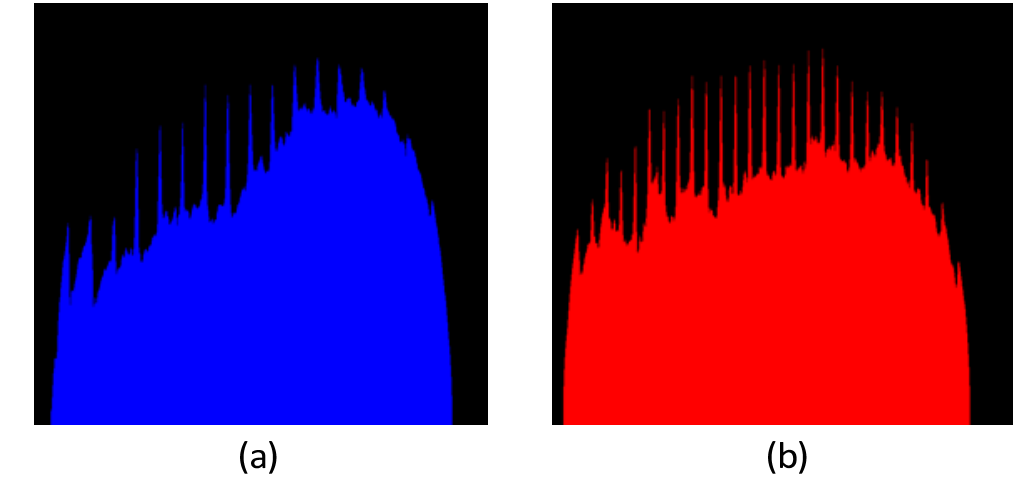
Figure 10. The projections of the accumulated values in ( a ) the columns and ( b ) the